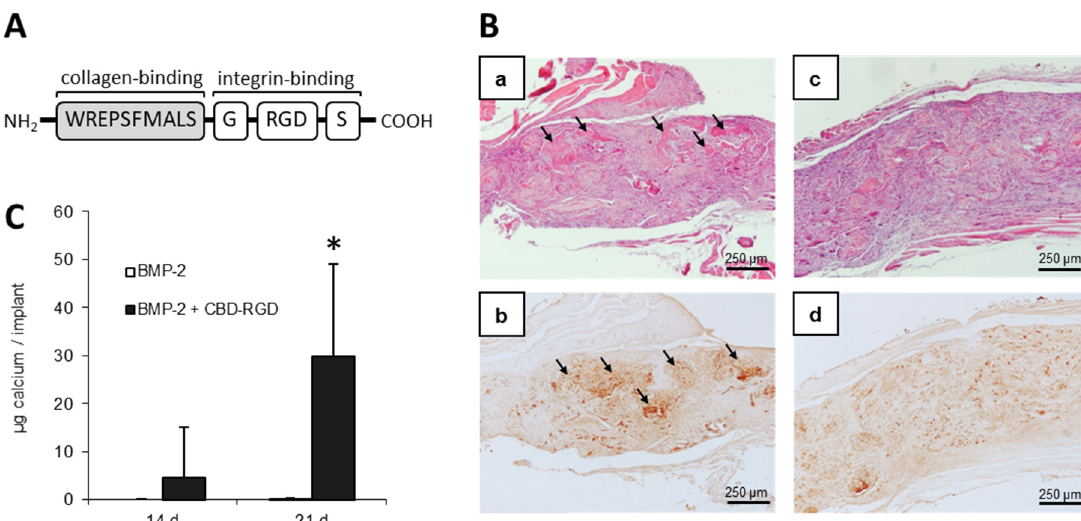
Figure 6. Biological activity of a collagen binding domain-Arg-Gly-Asp (CBD-RGD) synthetic peptide. ( A ) Schematic representation of the CBD-RGD peptide. ( B ) Ectopic bone formation in rats. Collagen type I sponges were functionalized with the CBD-RGD peptide ( a , b ) or not ( c , d ), loaded with 300 ng of BMP-2 and intramuscularly implanted in rats for 21 days. Upper images ( a , c ) are hematoxylin-eosin stained sections of the implants showing mature bone trabeculae in the sponges that had been functionalized with CBD-RGD. Lower images ( b , d ) correspond to anti-osteopontin immunohistochemistry. Arrows: bone trabeculae containing osteoblasts. ( C ) Calcium content of the recovered ectopic implants. No detectable calcium could be found within the non-fuctionalized implants. Contrarily, a significant amount of calcium was measured in the ectopic implants after 21 days. * p ≤ 0.01. Modified from